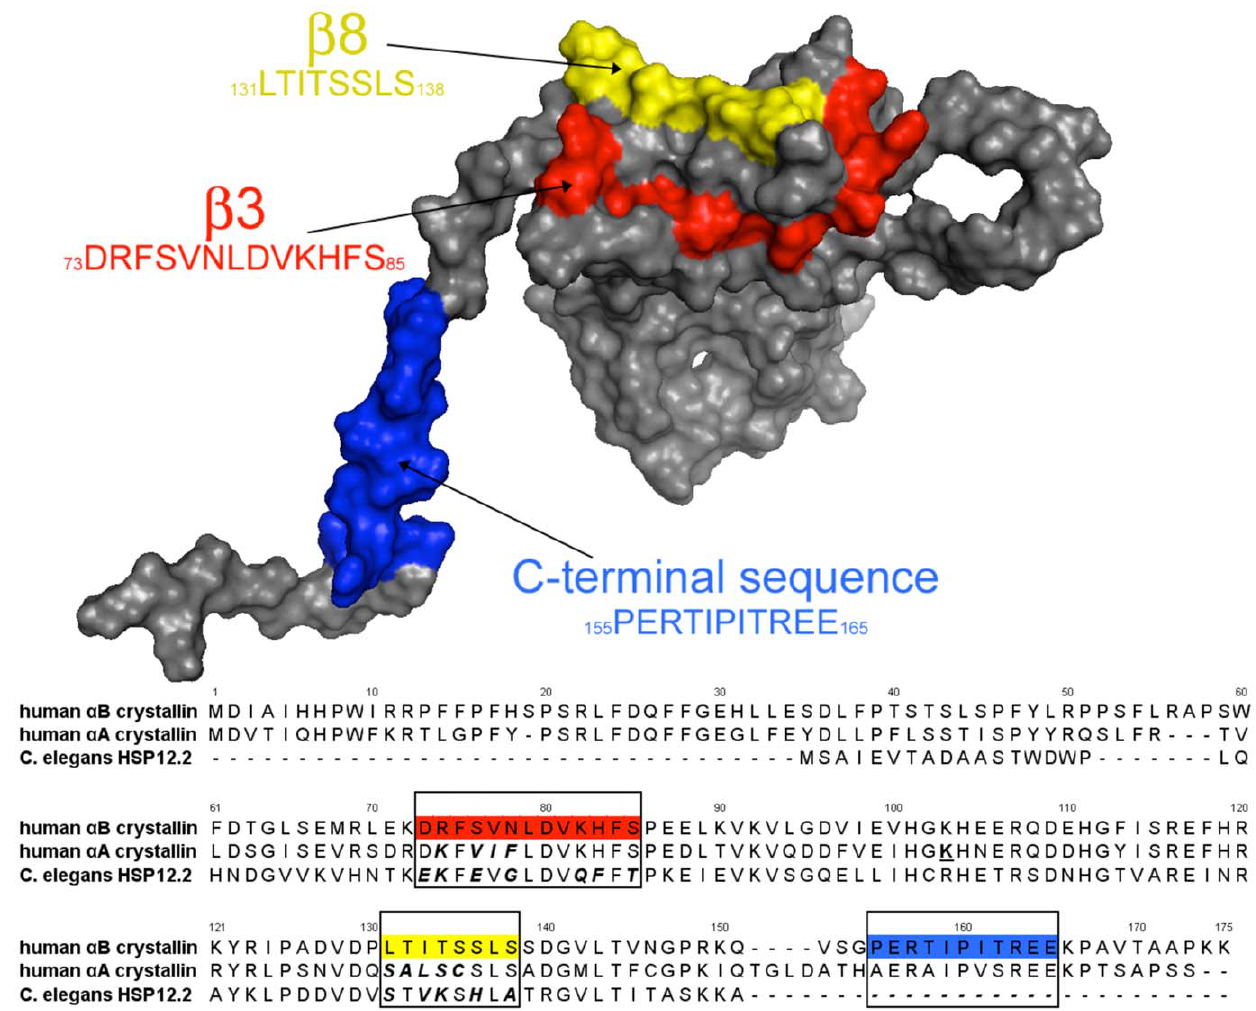
Figure 1. Location of IF interactive domains in b 3-strand (red), b 8-strand (yellow), and C-terminal 155–165 residues (blue) of human wild-type a B-crystallin. The primary sequences for human wild type a B-crystallin, human wild type a A-crystallin, and C. elegans wild type HSP12.2 were aligned using the residue numbers for human a B-crystallin in ClustalX. The boxes and colors in the a B-crystallin sequence correspond with the interactive sequences labeled on the surface of the 3D model. The amino acid substitutions in the a B-crystallin protein constructs are indicated by bold-italics . The b 3-strand of a B crystallin, 73 DRFSVNLDVKHFS 85 , was replaced with the corresponding sequences from a A-crystallin, DKFVIFLDVKHFS ( a A b 3), or HSP12.2, EKFEVGLDVQFFT (CE b 3). The b 8-strand of a B-crystallin, 131 LTITSSLS 138 , was replaced with the corresponding sequences in a A- crystallin, SALSCSLS ( a A b 8), or HSP12.2, STVKSHLA (CE b 8). The 155–165 residues were deleted in a B-crystallin to create the D 155–165 protein construct. The CE b 3, CE b 8, and D 155–165 a B-crystallin protein constructs were designed to target the desmin interaction